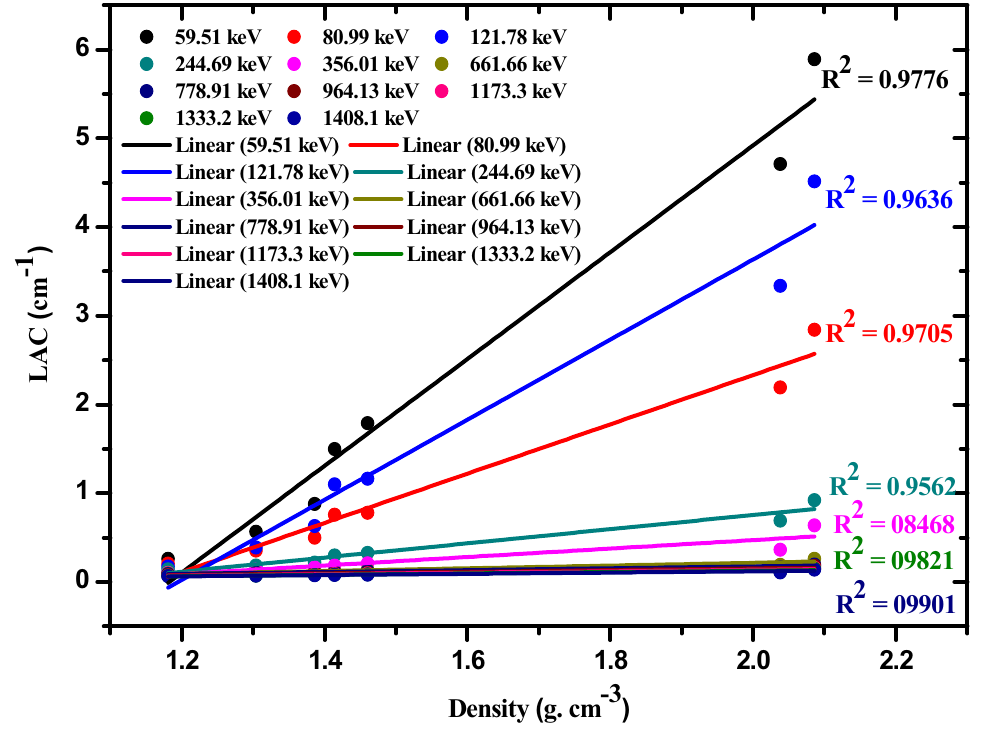
Figure 8. The relationship between LAC for nano- and micro-PbO and their densities at different energy photon.